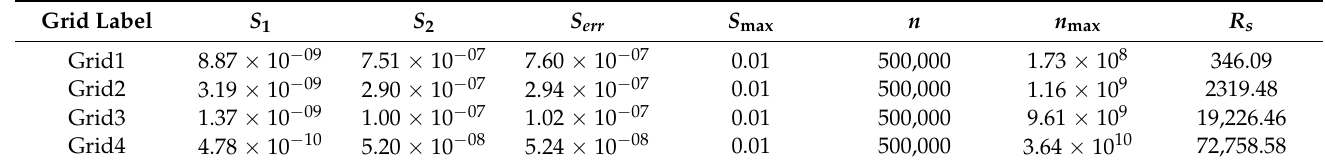
Table 5. Grid independence analysis